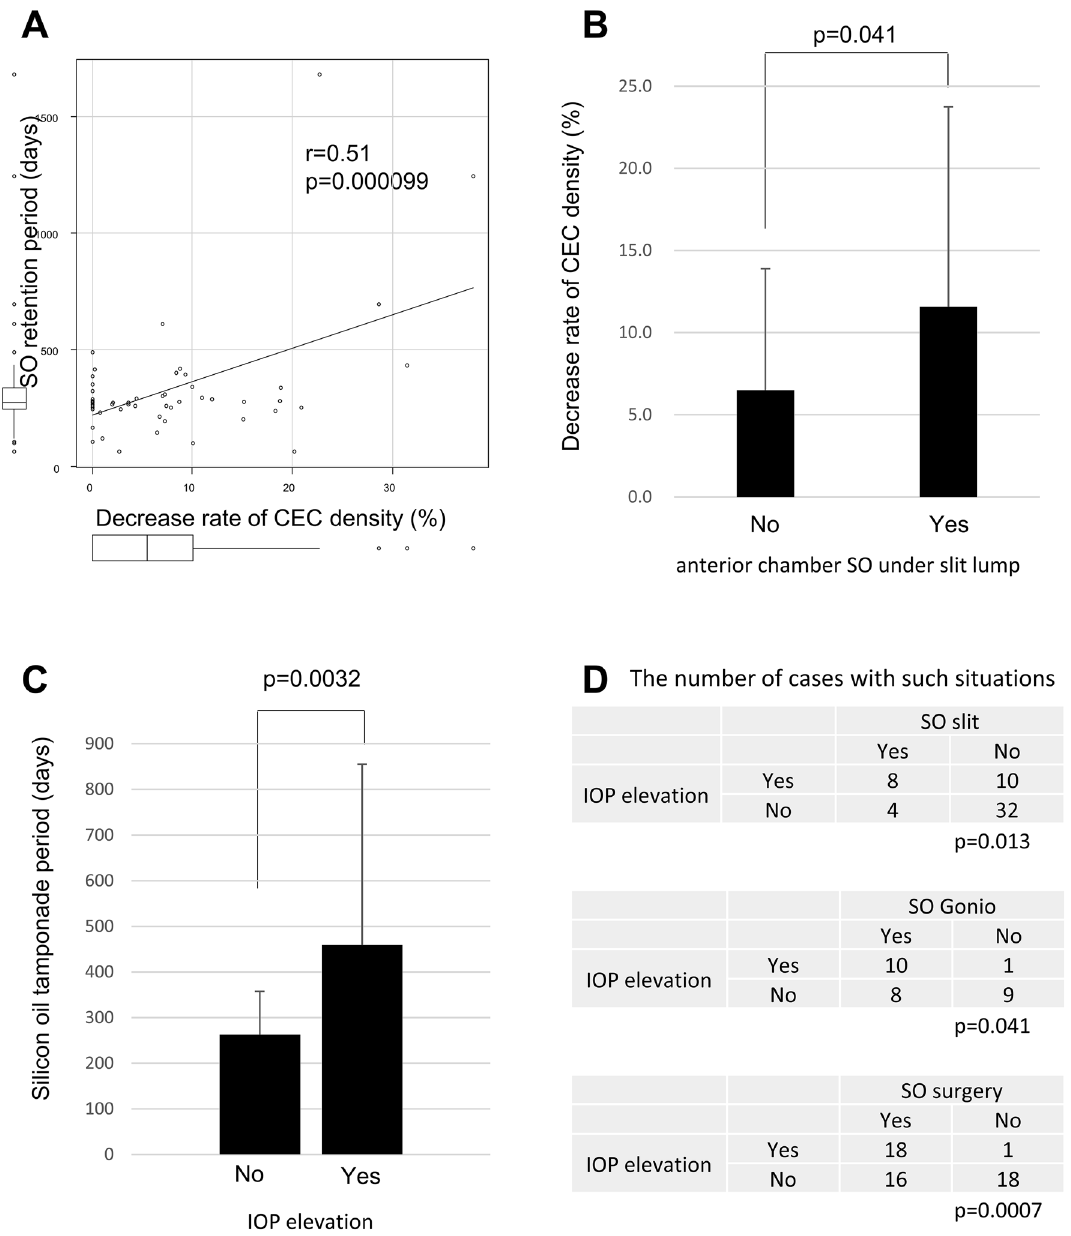
Figure 3. Decrease rate of corneal endothelial cell (CEC) density and intraocular pressure (IOP) elevation with some situations of silicone oil (SO) tamponade. High correlation was observed between decrease rate of CEC density and SO tamponade retention period ( A ). Correlation between anterior chamber SO under slit lamp and the decrease rate of CEC density ( B ). The SO tamponade period was significantly longer in cases with elevated IOP ( C ). Correlation between anterior chamber SO under gonioscope, anterior chamber SO under slit lamp, and SO attaching area with surgical microscope with IOP elevation ( D